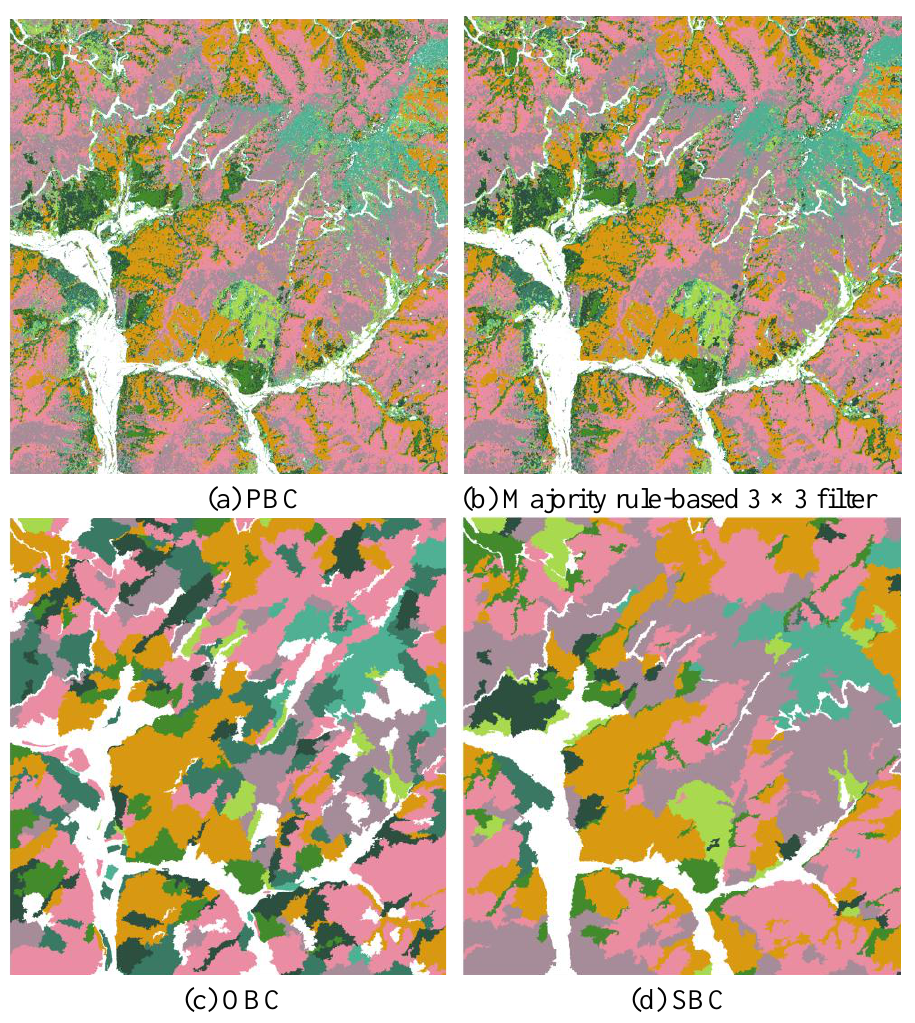
Figure 6. Forest cover maps generated by pixel-based (PBC), majority rule-based, object-based (OBC), with a color parameter of 0.5 and a scale parameter of